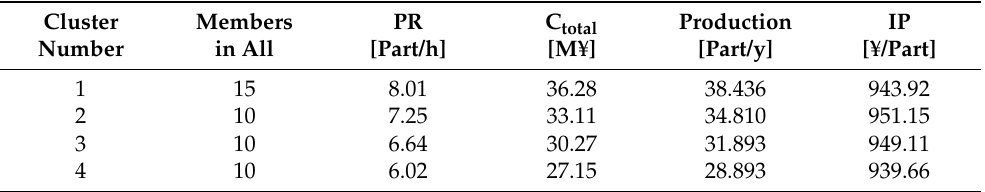
Table A7. Cluster analysis of the original approach [4] (Case B).